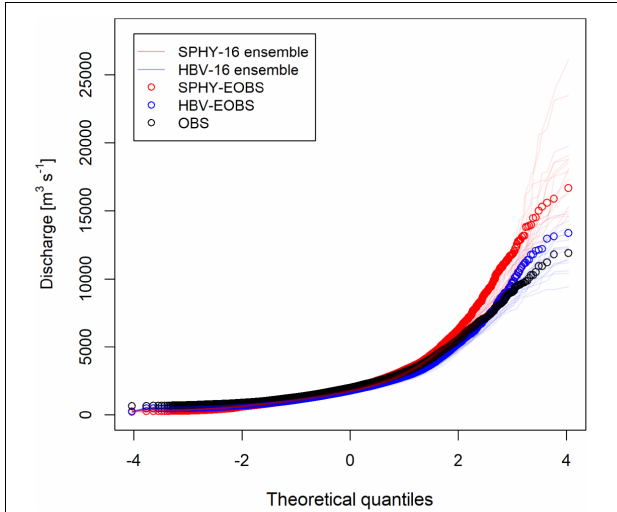
FIGURE 4 | Normal quantile plot for HBV (blue), SPHY (red) and Observation (black). On the horizontal axis, the distributions are centered and scaled (divided by the standard deviation). The light blue and red lines represent 16 ensemble members for HBV and SPHY.